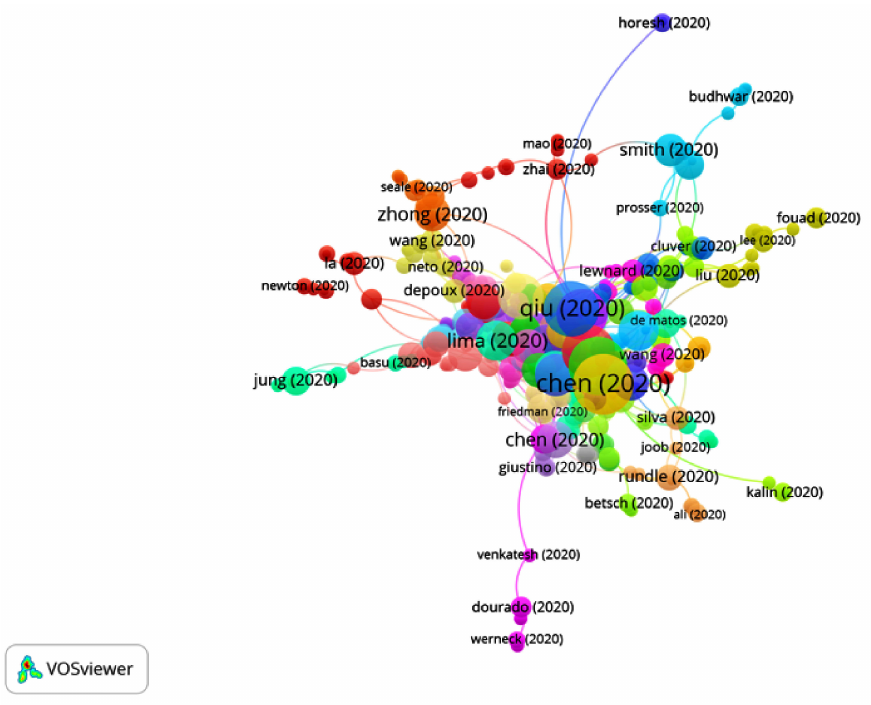
Figure 9. Citation network for Group